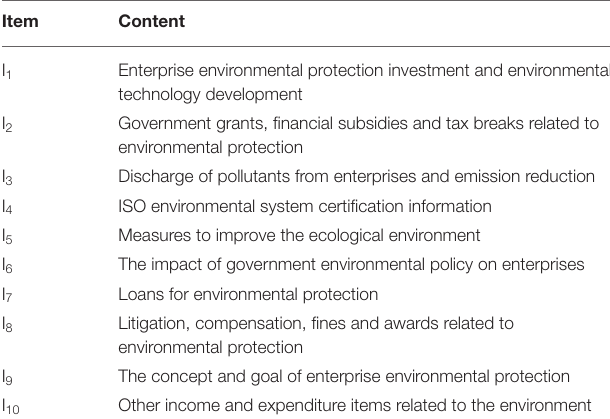
TABLE 1 | Measurement items for